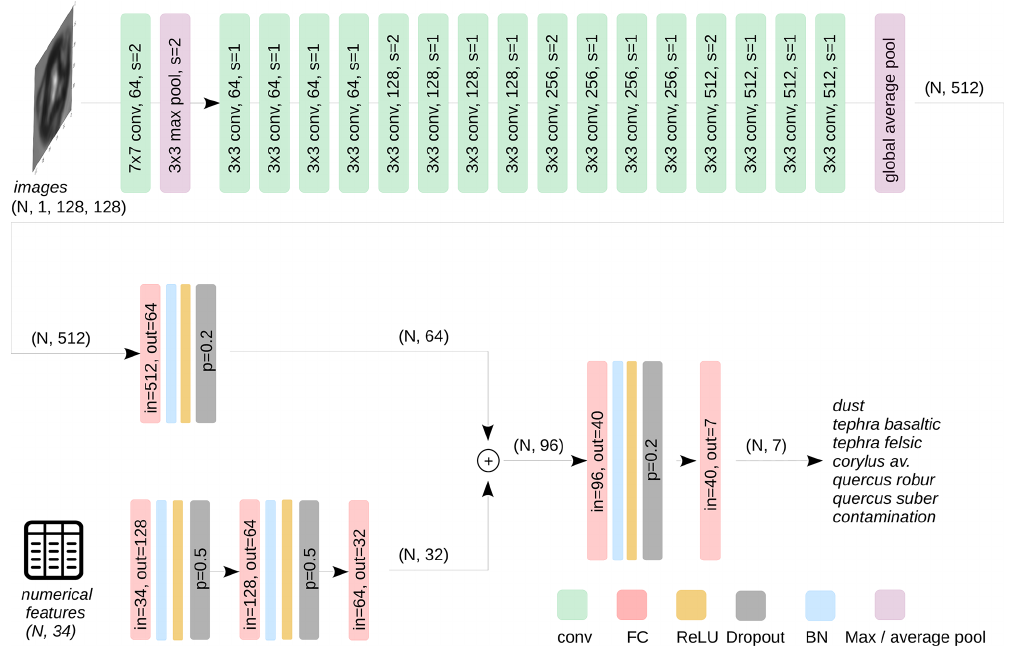
Figure 1. Model architecture. The top branch of the network is a ResNet-18 CNN (He et al., 2016). BN, ReLU layers, and skip connections are omitted for clarity. The bottom branch operates on the numerical features and consists of three-layer multilayer perceptron. The separate outputs of the two branches are concatenated into a final classification branch. Indicated in parentheses are the input and output shapes of some layers along the